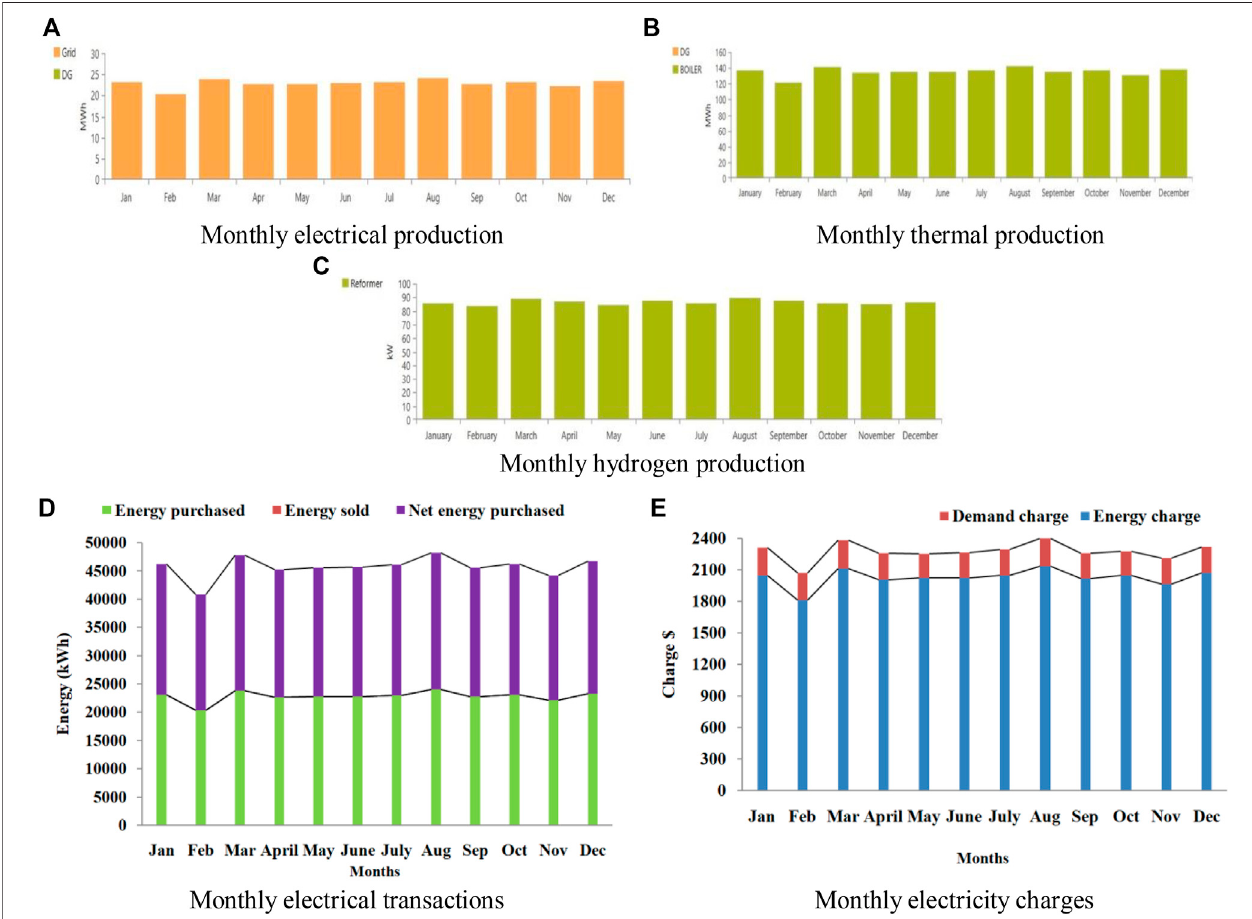
FIGURE 11 | Monthly energy productions, transactions, and charges. (A) Monthly electrical production. (B) Monthly thermal production. (C) Monthly hydrogen production. (D) Monthly electrical transactions. (E) Monthly electricity charges.